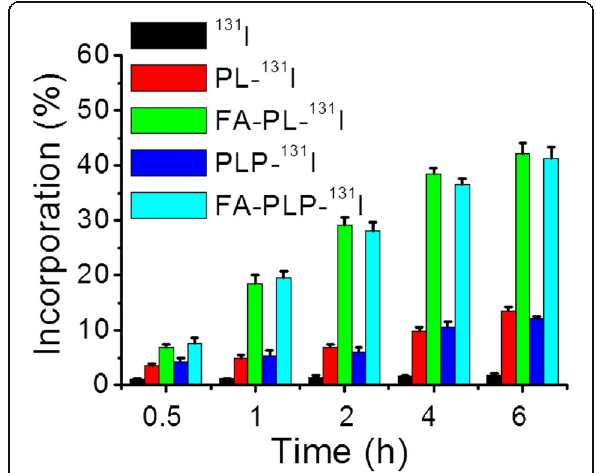
Fig. 4 Time-dependent incorporation of 131 I, PL- 131 I, FA-PL- 131 I, PLP- 131 I, and FA-PLP- 131 I on B16F10 cells